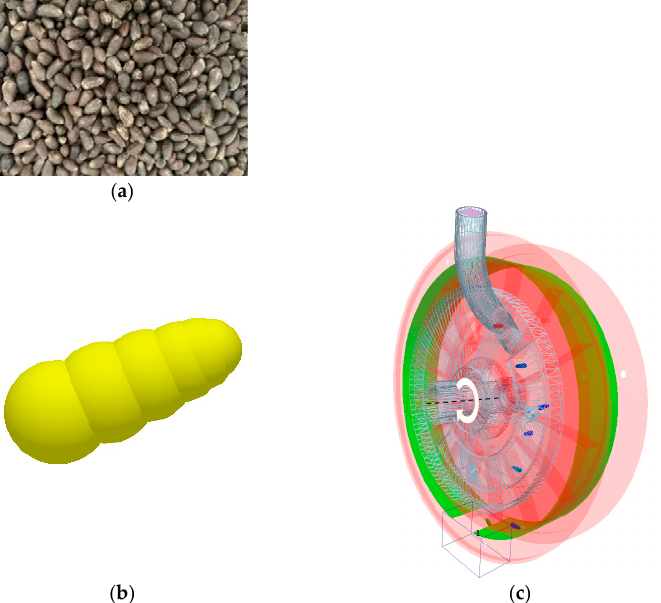
Figure 11. Cotton seed and hole sower simulation model. ( a ) Physical cotton seed pellets; ( b ) Cotton seed simulation model; ( c ) Simulation model of a hole sower. The material and contact parameters required for the simulation are shown in Table 1 [35]. The pellet plant was set up directly above the secondary seeding opening. It pro ‐ duced cotton seed pellets at fixed intervals, with the seeding interval coinciding with the rotation of the seeding disc to ensure that adjacent seeds entered the adjacent compart ‐ ment, and the initial seeding speed was set at 3 m/s. A transparent inoculum box below the hole sower was used to count the cotton seed pellets, replace the duckbill, and evaluate operational performance. Table 1. Parameters used in the DEM simulations. Parameters